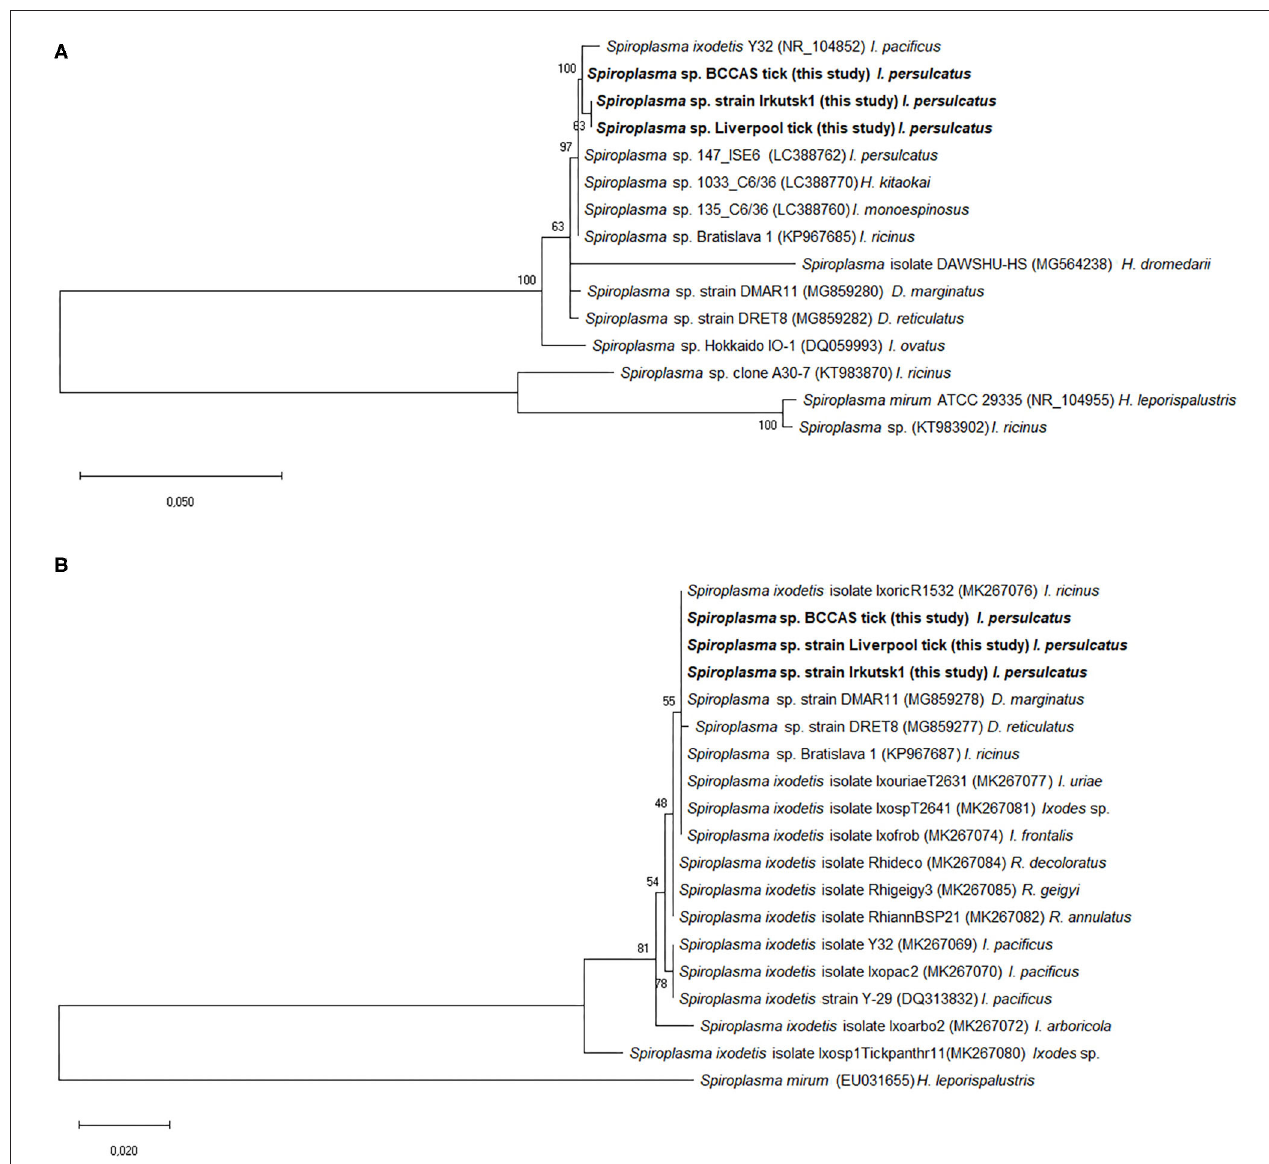
FIGURE 2 | Phylogenetic analysis of Spiroplasma gene sequences obtained from third generation Ixodes persulcatus colony ticks. Sequences amplified from DNA extracted from representative adult Ixodes persulcatus ticks at the University of Liverpool (Liverpool tick) and the Institute of Parasitology, Biology Centre, Czech Academy of Sciences (BCCAS tick) and from a representative Spiroplasma -infected tick cell culture previously inoculated with internal organs from an adult I. persulcatus ( Spiroplasma sp. strain Irkutsk1) were compared with published sequences from other Spiroplasma spp. or strains derived from ixodid tick species. The evolutionary analysis was inferred using the maximum likelihood method and Kimura 2-parameter model within the Mega X software. The trees are drawn to scale, with branch lengths measured in the number of substitutions per site. GenBank accession numbers of the sequences used in this analysis are shown in brackets following each Spiroplasma species or strain and before the tick species host. Sequences obtained in this study are marked in bold. (A) Tree constructed from 15 16S rRNA nucleotide sequences and a total of 461 positions in the final dataset. (B) Tree constructed from 19 rpoB nucleotide sequences and a total of 588 positions in the final